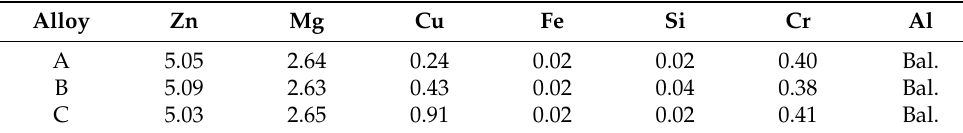
Table 1. Chemical compositions of Al-5Zn-2.6Mg-xCu aluminum alloys (wt. %). Alloy Zn